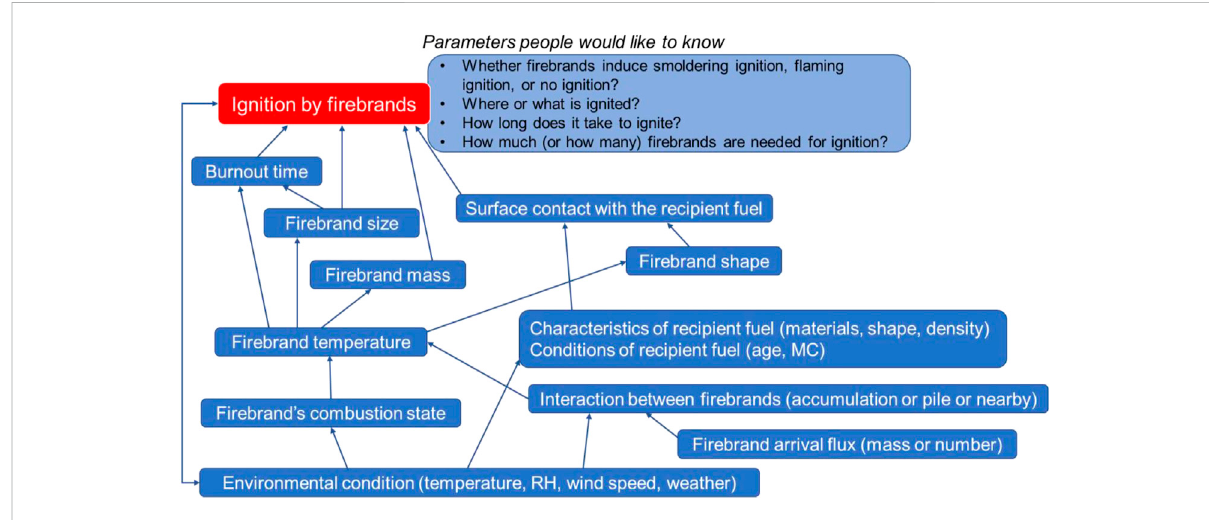
FIGURE 10 A listing of important factors that in fl uence fi rebrand ignition processes.